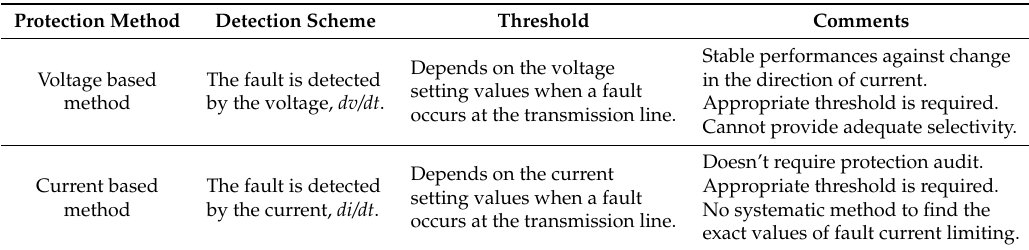
Table 1. Summary of fault protection methods in the DC